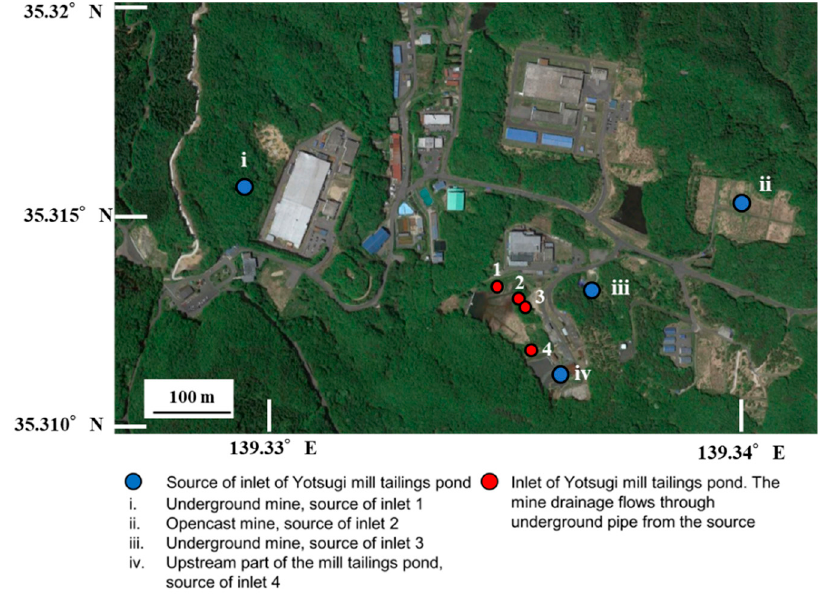
Figure 1. Inlet points of acid mine drainage in the Yotsugi mill tailings pond.